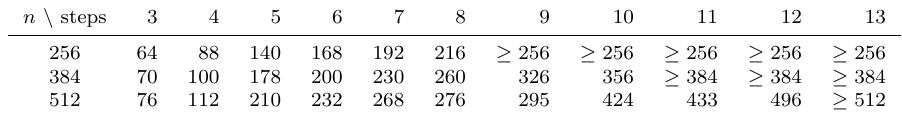
Table 6: The quantity − log ( 𝑝 ) where 𝑝 is the differential bound for several steps of 2 Sparkle for different block sizes. For 1 and 2 steps, we always have that − log equal to 6 and 32